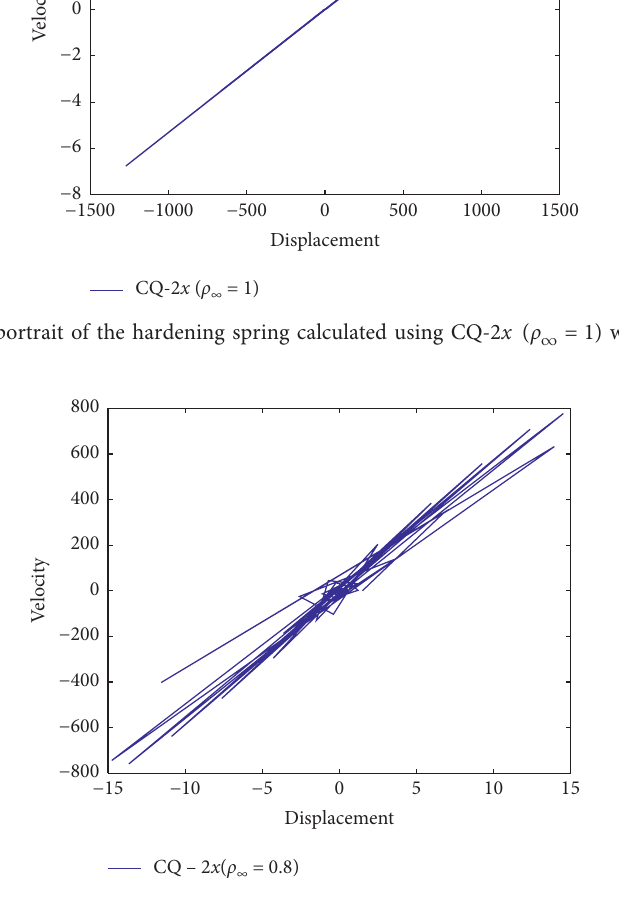
� 0 . 8 ) when Δ t � ( 1/2 ) T . ∞